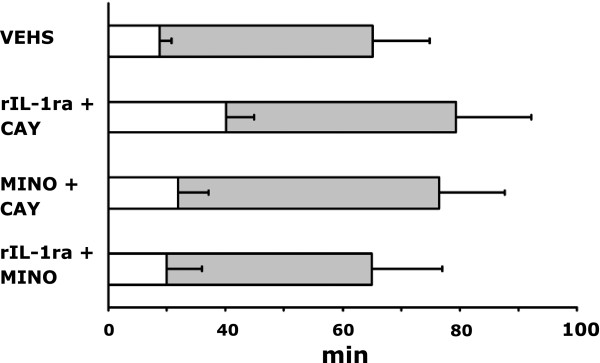
Status epilepticus (SE) after administration of lipopolysaccharide (LPS) with or without anti-inflammatory drugs. Mean (± SEM) of both time to onset (open bar) and total duration (open + filled bar) after pilocarpine treatment following a prior injection of LPS or LPS + combination of anti-inflammatory drugs. The latency to pilocarpine-induced seizure onset in combination treatment of COX-2 inhibitor plus rIL-1ra with LPS was significantly delayed as compared to those given vehicle (*P <0.01). There were no significant changes in total duration of SE among groups. CAY, COX-2 inhibitor; MINO, minocycline; rIL-1ra = recombinant interleukin-1 receptor antagonist; VEHS, vehicles.